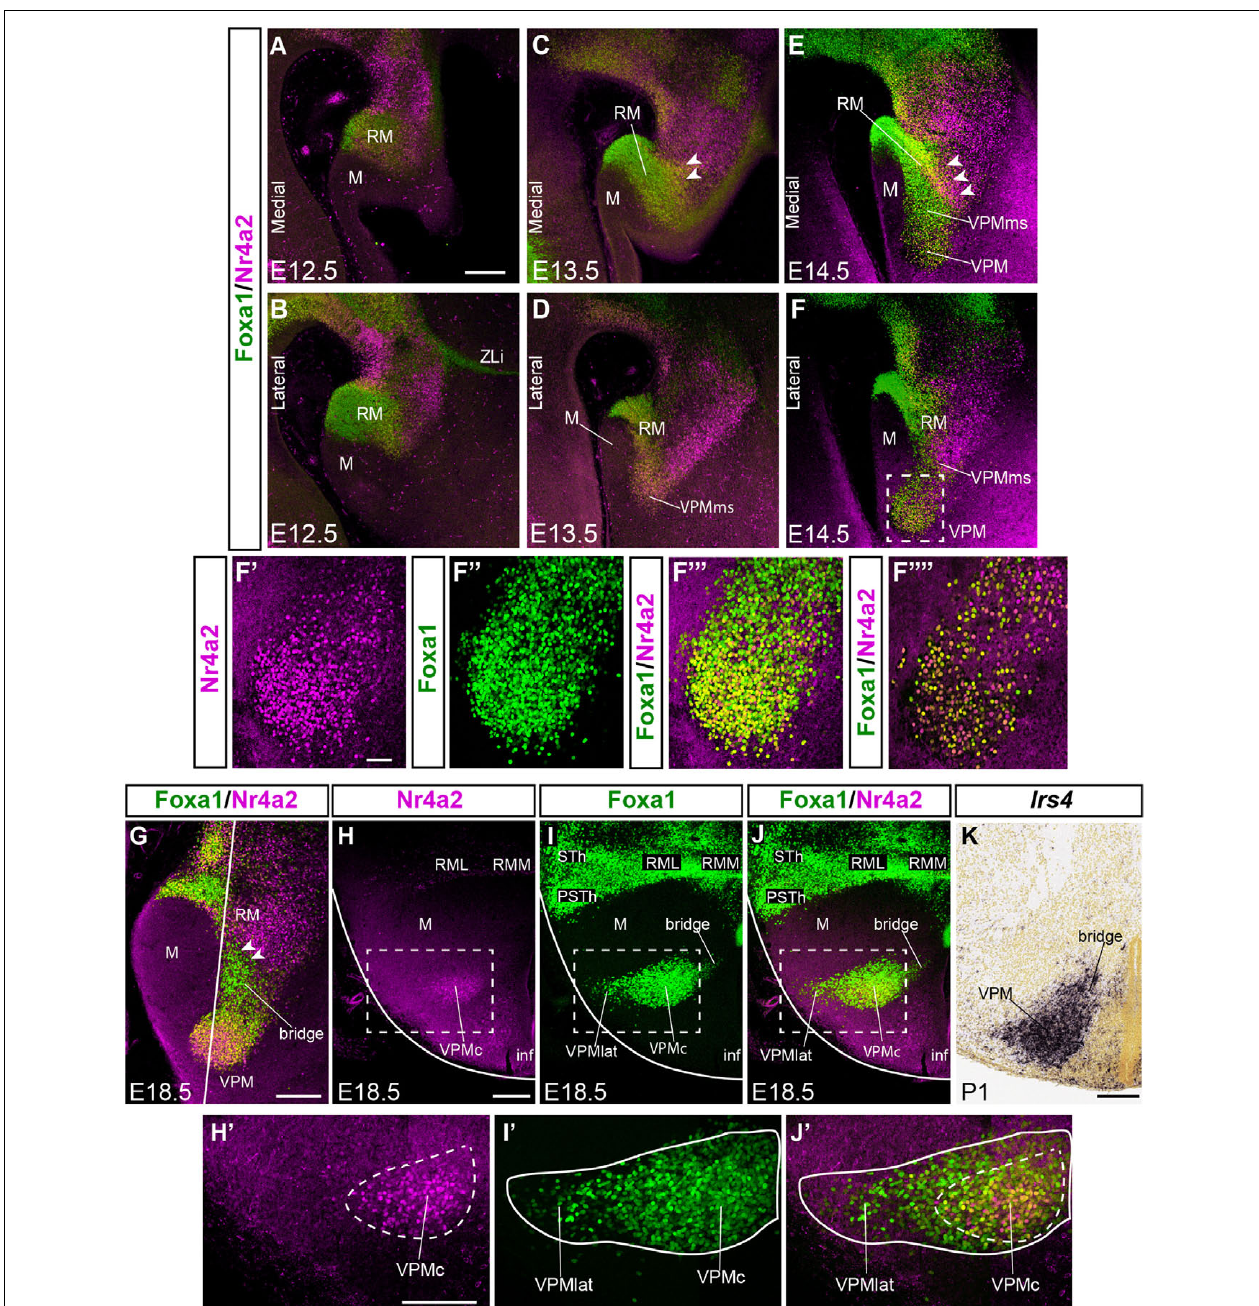
FIGURE 2 | Comparison of Foxa1 and Nr4a2 signal during VPM development. (A–F) Double immunofluorescence of Foxa1 (green) and Nr4a2 (magenta) in medial (A,C,E) and lateral (B,D,F) sagittal sections of E12.5, E13.5, and E14.5 mice embryos, showing RM, M, VPMms, and the prospective VPM. Distinct ventral Foxa1 and dorsal Nr4a2 RM domains are observed, with an intermediate yellow (double-labeled) subpopulation, best visible in (C,E) (white arrowheads). (F’–F”’) High magnification images of the square area dashed around VPM in (F) showing the separate magenta and green channels (F’,F”) and their conjunction (F”’) thinner, with apparently double-labeled cells. These are confocal reconstructions of a 50 mm-thick stack of 3 µ m optical slices. The image in (F””) shows a similar, but only 3 mm-thick stack, indicating that double-labeled cells really exist. (G) Sagittal section at E18.5 illustrating the differential distribution of Foxa1 and Nr4a2 cells within RM, VPM, and the RM-VPM connecting bridge, ventrally composed by Foxa1 cells (white arrowheads). The white line indicates the plane of section used for panels (H–J) . (H–J) Horizontal sections showing the differential medio-lateral distribution Foxa1 and Nr4a2 VPM cells at E18.5. (H,H’) Nr4a2 marks RM and the core of VPM -VPMc. (I,I’,J,J’) Foxa1 labels the RM, lateral (superficial shell) and core parts of VPM -VPMlat, VPMc-, as well as the separate STh and PSTh migrated populations. (K) This horizontal section similar to those in (H–J) but labeled with Irs4 ISH at P1 shows the VPM and its persistent bridge. Scale bar in (A) represents 200 µ m, valid also for (B–F) . Scale bars in (G,H) represent 200 µ m (valid also for I–K ). Scale bar in (F’) represents 75 µ m (valid also for F”,F”’ ).